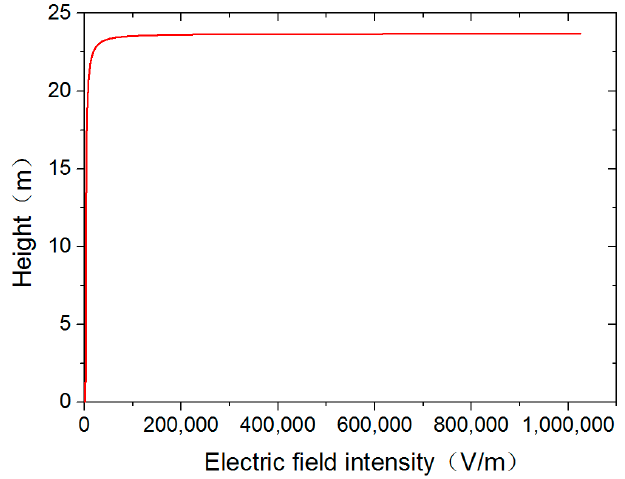
Figure 7. Electric field distribution curve under the 220 kV transmission line.